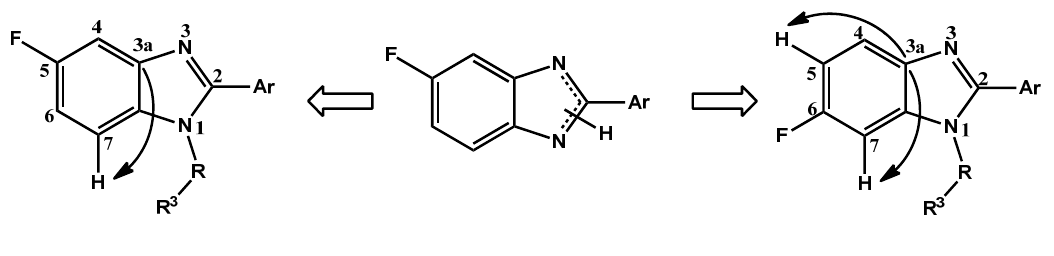
Figure 3. HMBC correlations in regioisomeric